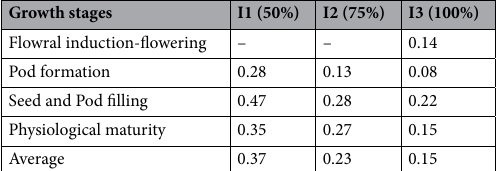
Table 8. CWSI threshold and average values during black gram growth period.